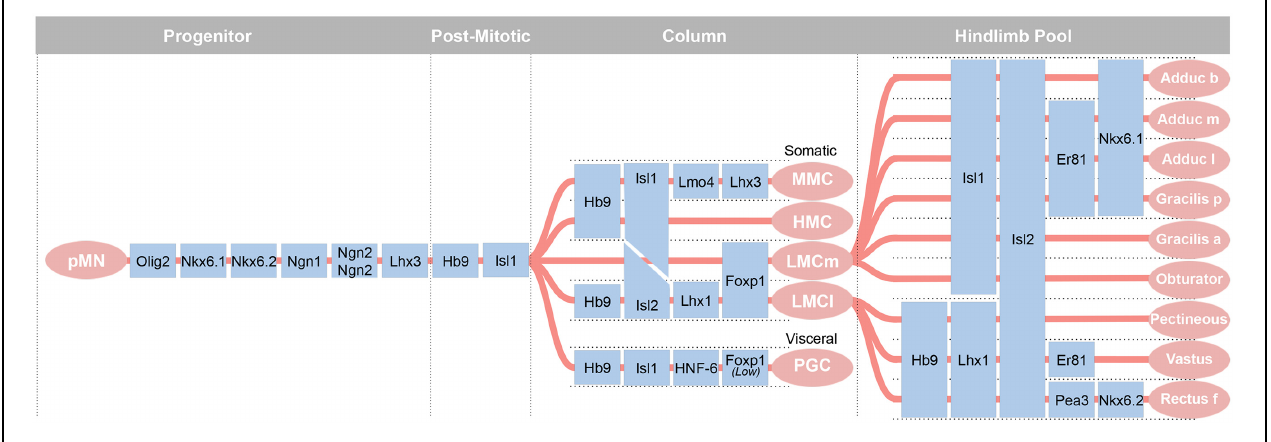
FIGURE 3 | The most diverse spinal cord neuron class belongs to the motor neurons. These arise from a uniform progenitor domain before differentiating in to classes that can be grouped by columns and by motor